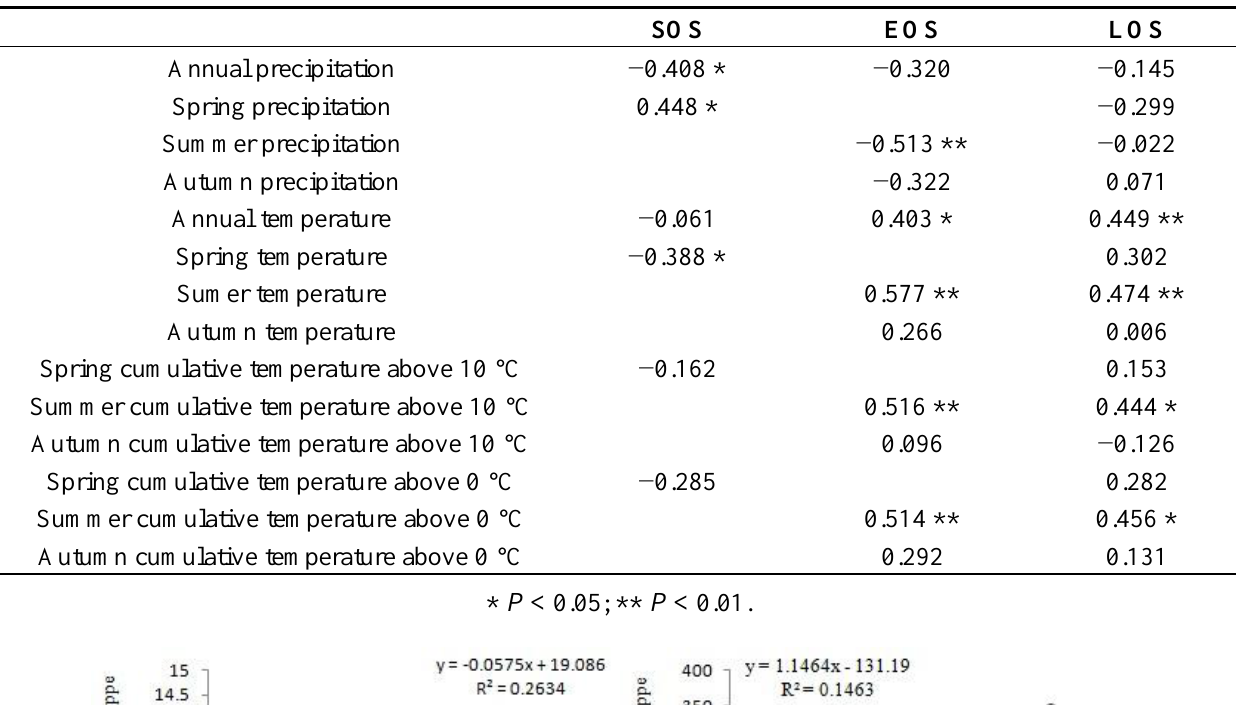
Table 3. Correlation coefficients between phenological parameters and climatic factors in the forest region.